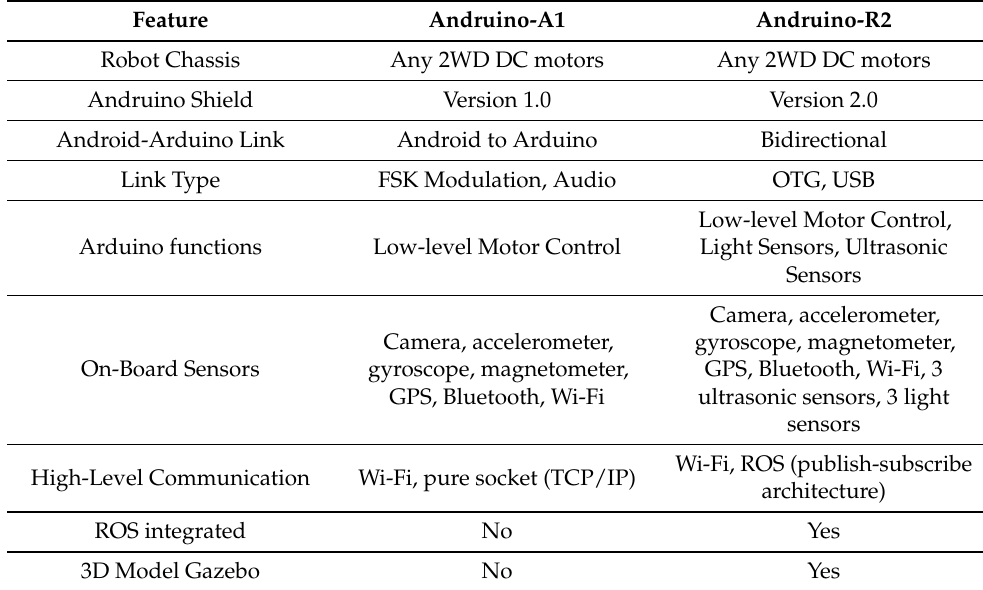
Table 1. Comparison of Andruino-A1 and new